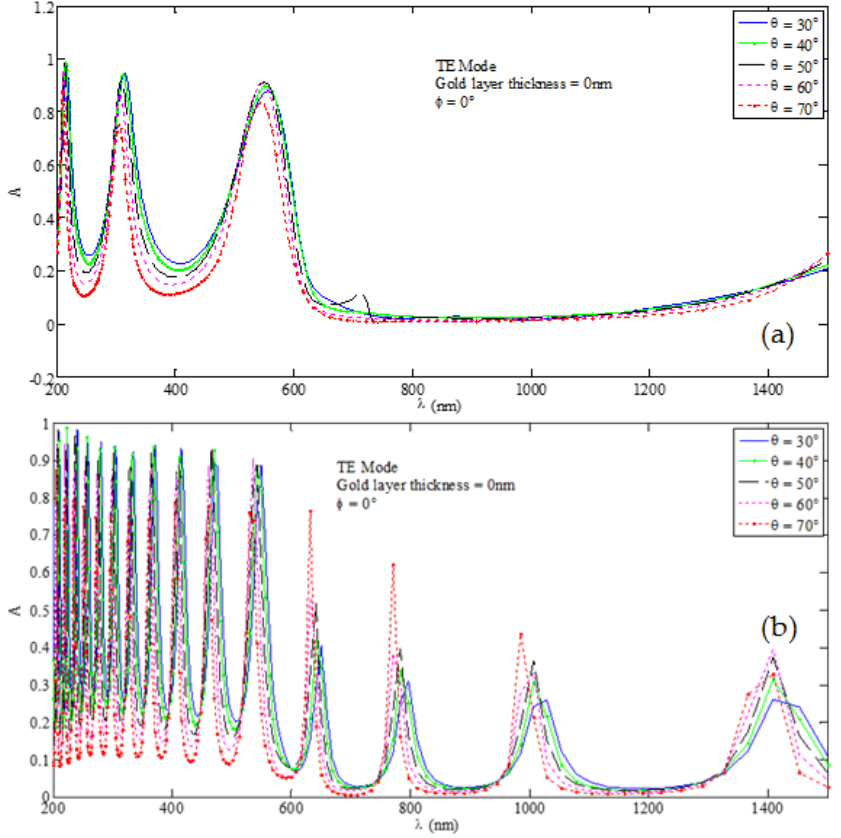
Figure 11. Absorption spectra obtained for 𝑑 = 0 under the TE wave excitation incidence and corresponding to ( a ) 𝑡 = 100 nm and ( b ) 𝑡 = 500 nm.